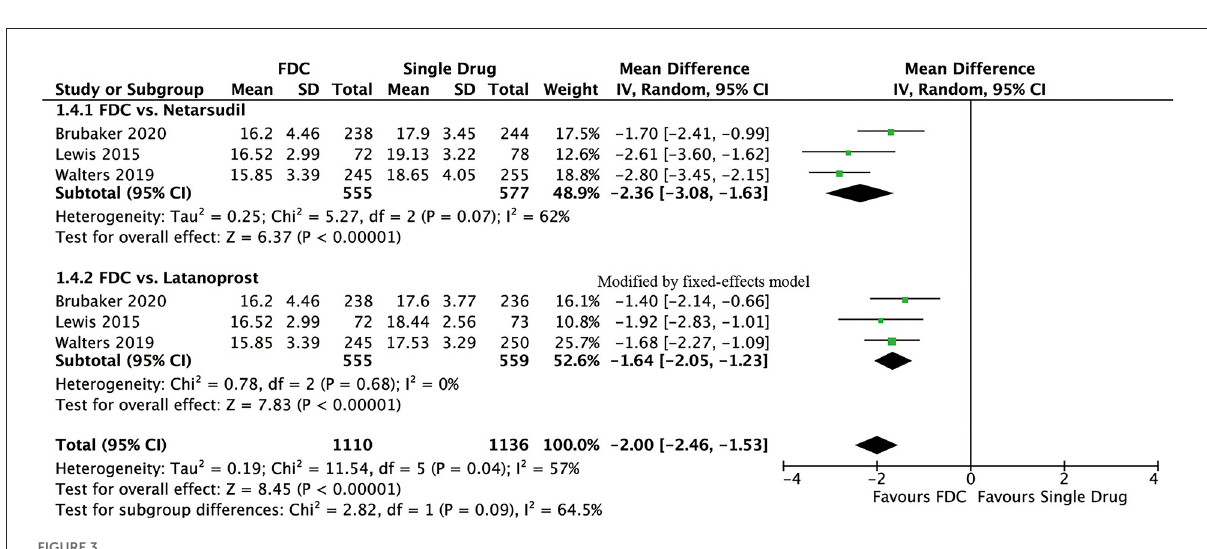
FIGURE3 Forest plot of WMD of mean diurnal IOP associated with FDC vs.